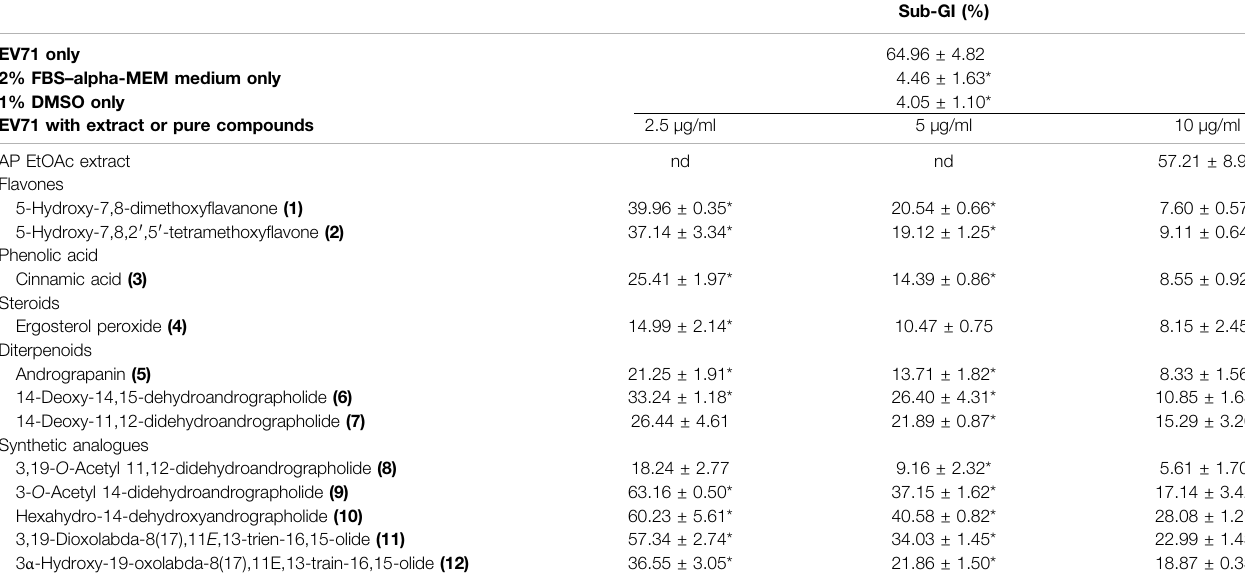
TABLE 1 | Anti-EV71-induced cytotoxicity of AP EtOAc extract and its pure compounds evaluated by the decrease in percentage of sub-G1 population in EV71-infected RD cells.